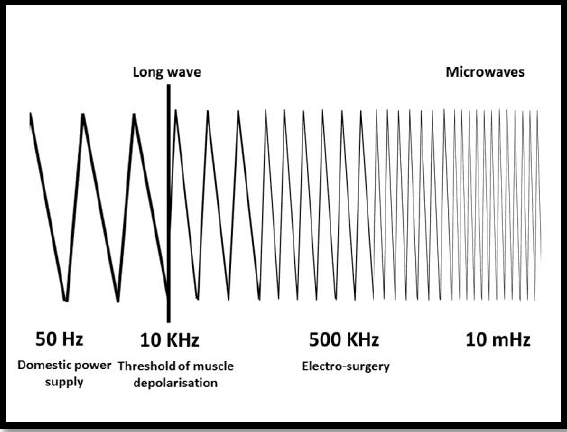
Figure 1: Schematic figure of the electrosurgical generator that converts the 50-60 cycles AC current to 300-500 K Hz frequency that produces various surgical effects at the hand piece. Figure 5: Circuit of a bipolar electrosurgical system.